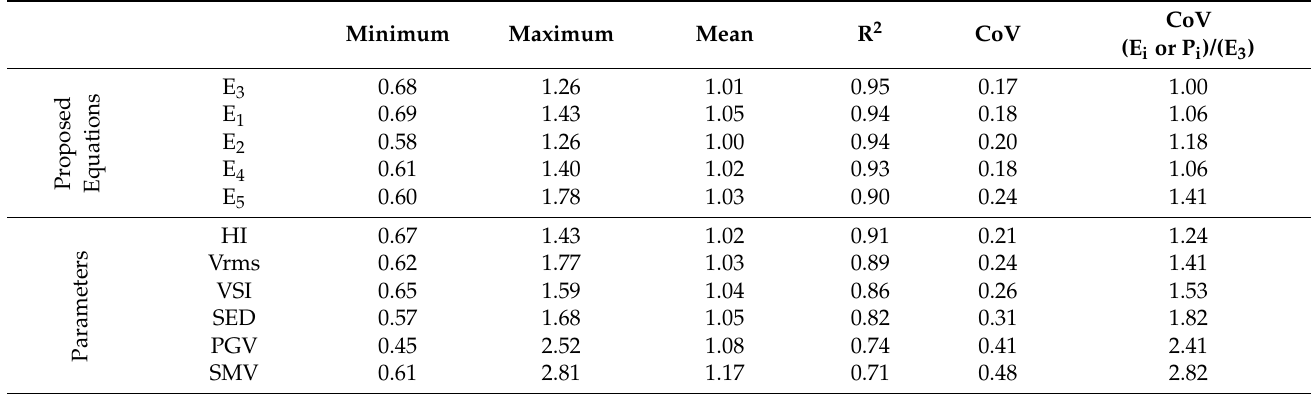
Table 10. Statistics for the ratio of the proposed equations to analysis